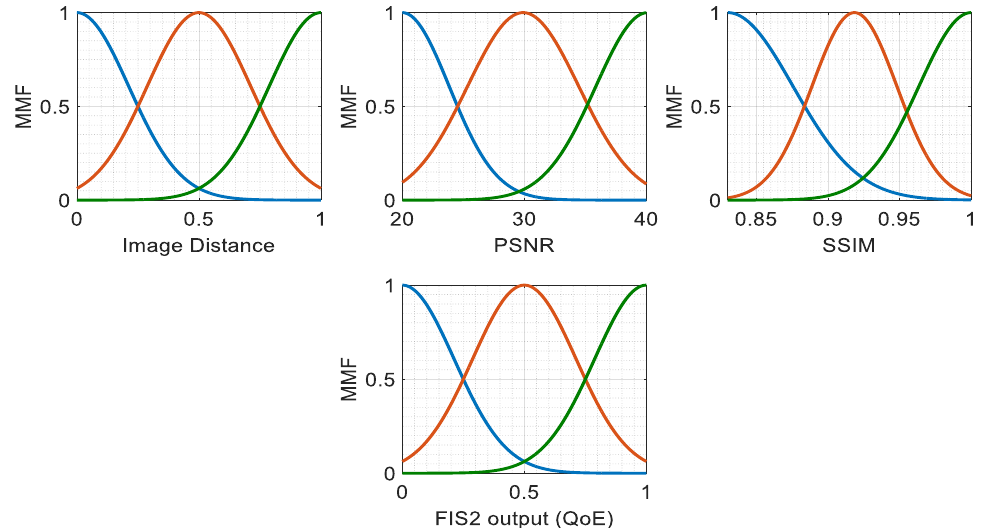
Figure 5. FIS2 membership functions (MMF), inputs (top figures) and output (bottom figure)